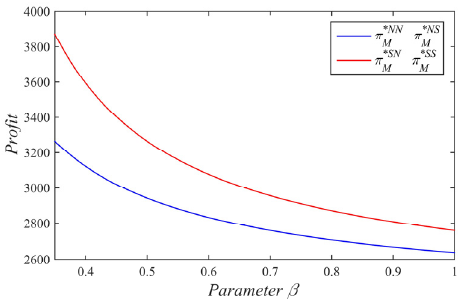
β β β on the profits of manufacturer. on the profits of manufacturer. on the profits of manufacturer.